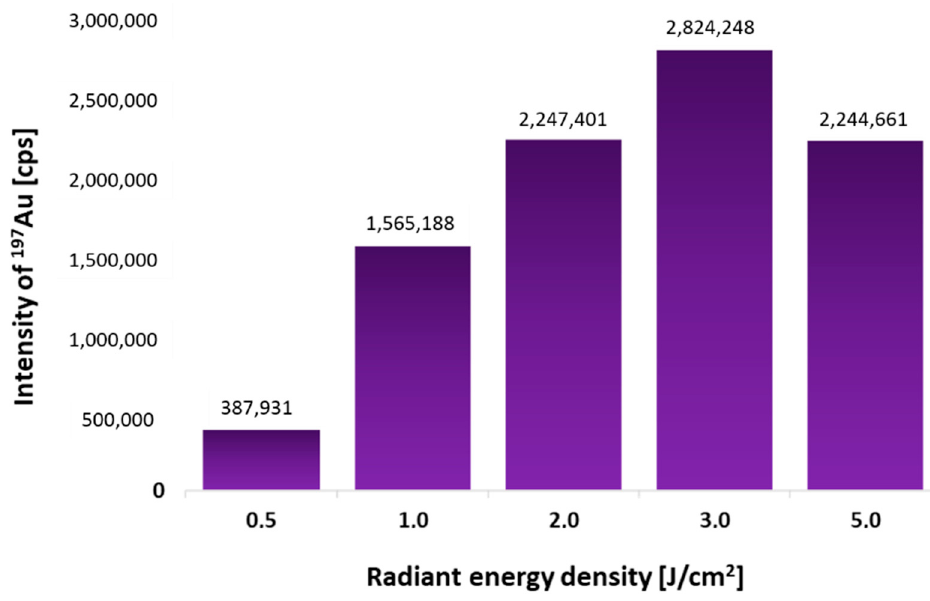
Figure 1. Dependence of the measured Au intensities on the various radiant energy densities, while the amount of antigen applied to the PVDF membrane was